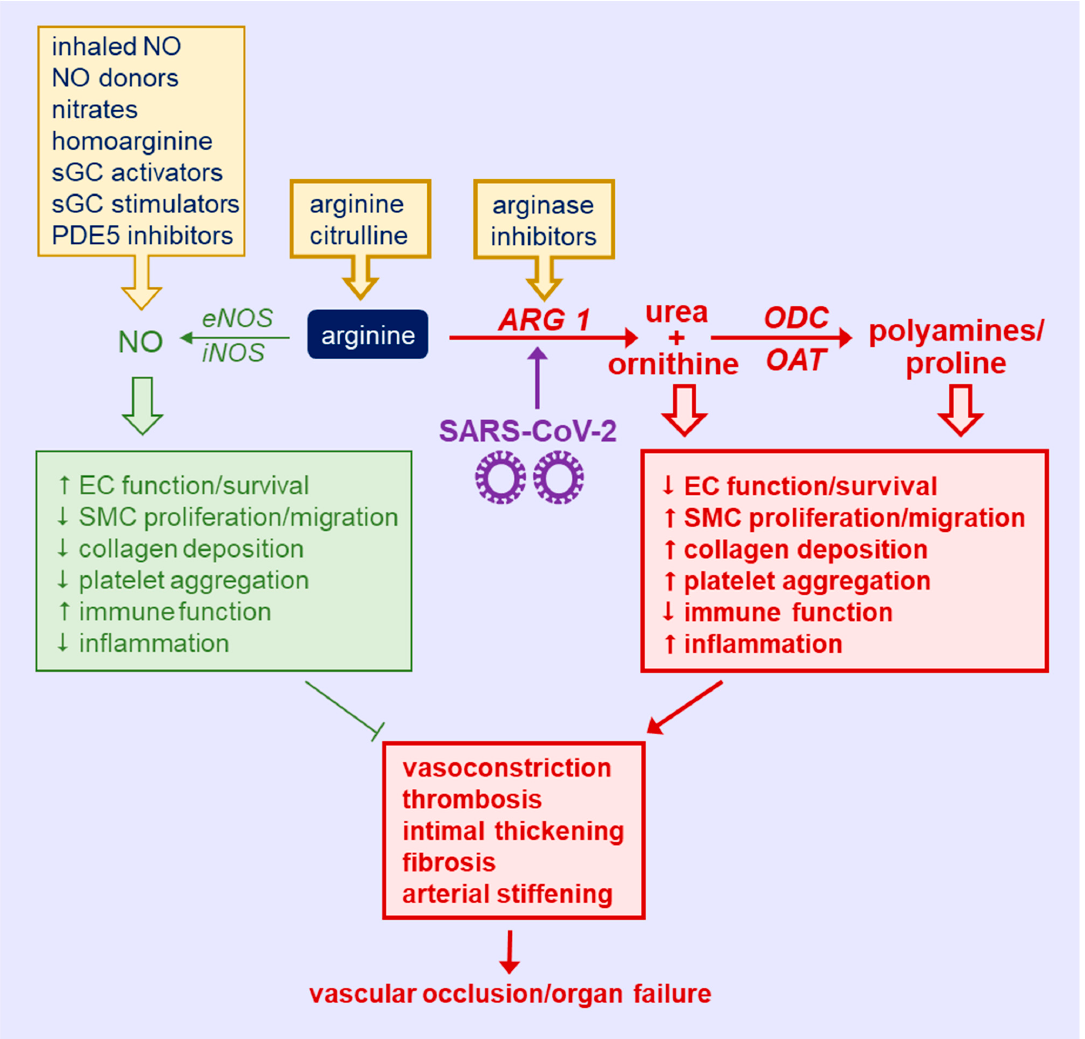
Figure 2. Targeting arginine in COVID-19-induced immune and vascular dysfunction. There is an upregulation of arginase 1 (ARG1) by the severe acute respiratory syndrome coronavirus 2 (SARS-CoV-2) that diminishes circulating arginine levels and shunts the metabolism of arginine away from the synthesis of nitric oxide (NO) by NO synthase toward the production of ornithine, which is subsequently converted to polyamines and proline via the action of ornithine decarboxylase (ODC) and ornithine aminotransferase (OAT), respectively. The induction of ARG1 causes immune malfunction, inflammation, and endothelial cell (EC) death and dysfunction, and stimulates vascular smooth muscle cell (SMC) proliferation, migration, collagen synthesis, and platelet aggregation, leading to vasoconstriction, thrombosis, arterial thickening, fibrosis, and stiffening. Collectively, these actions will promote vascular occlusion and organ failure. Several strategies may be used to target arginine in COVID-19. Dietary supplementation with arginine or citrulline provides a forthright approach to restore circulating levels of arginine in SARS-CoV-2-infected patients. Alternatively, the use of ARG inhibitors provides a more selective modality in correcting disturbances of arginine metabolism in COVID-19. In addition, the direct administration of arginine metabolites (inhaled NO, NO donors, inorganic nitrates, and homoarginine) or NO-potentiating drugs [soluble guanylate cyclase (sGC) activators or stimulators, and phosphodiesterase type 5 (PDE5) inhibitors] affords another avenue in treating COVID-19 patients. eNOS , endothelial nitric oxide synthase; iNOS , inducible nitric oxide synthase.